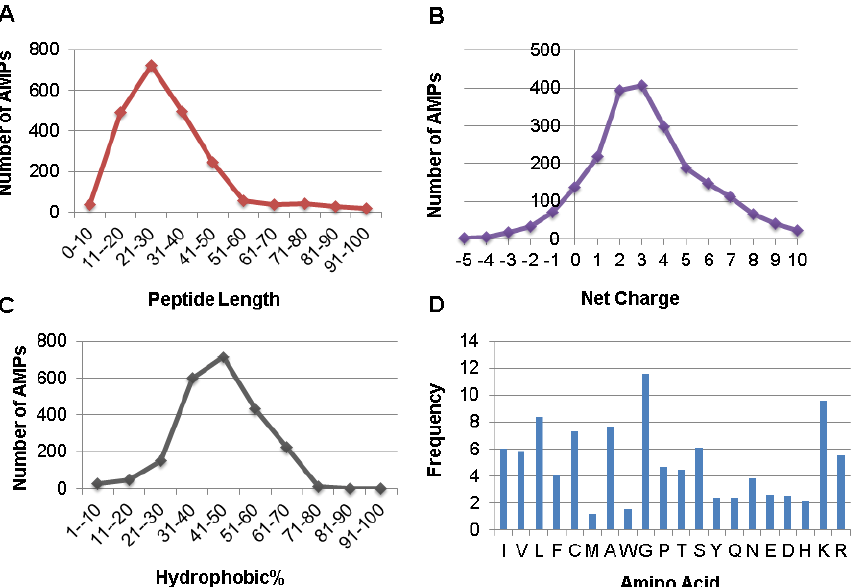
Figure 3. Distribution of AMPs as a function of peptide length ( A ), net charge ( B ), and hydrophobic% ( C ). The frequency of the 20 amino acids of AMPs in the APD ( D ). Data obtained from the APD ( http://aps.unmc.edu/AP )